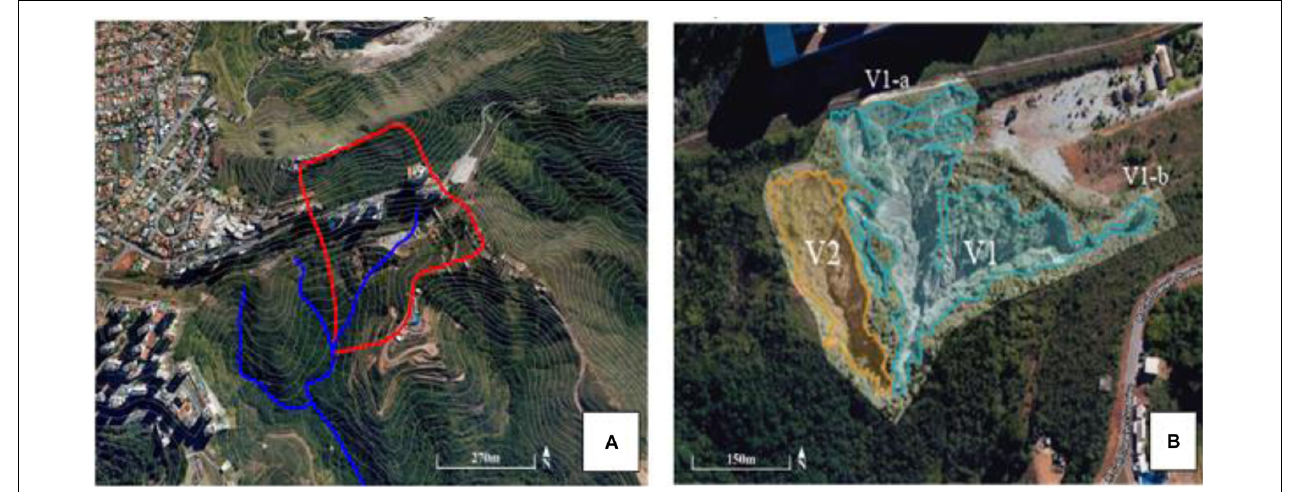
FIGURE 7 | “Estrangulado” Stream Area and UAV aerial visualization of existing gullies in Jardim da Torre, Nova Lima -MG. (A) Água Suja/Cardoso/Cristais sub-basin, belong to “das Velhas” river basin (Source: Google Earth, 2002–2019) – the red line delimits the sub-basin and the blue line represents the “Estrangulado” Stream; (B) V1 gully (incisions 1a and 1b) and V2 gully in 2019 (delimitation made from orthomosaics).